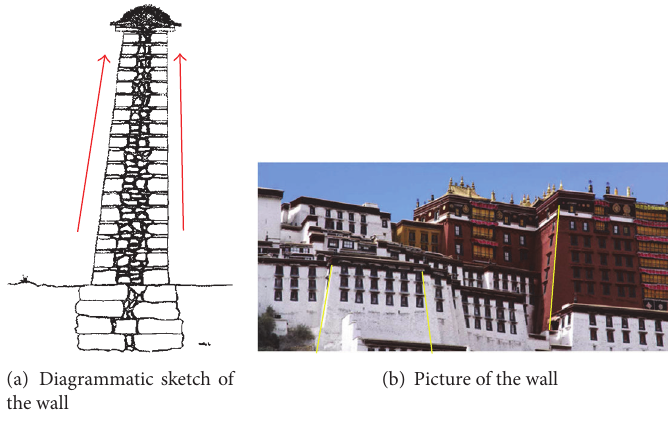
Figure 6: Outer wall with inward tilt.